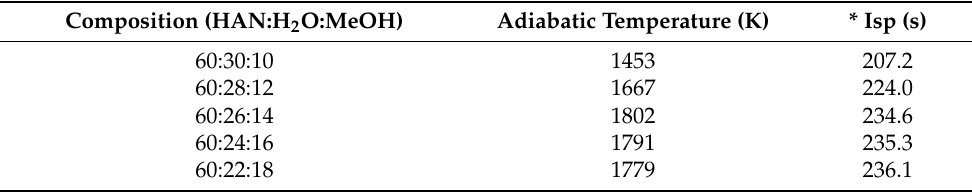
Table 1. Adiabatic temperature and specific impulse of methanol-blended HAN propellants.